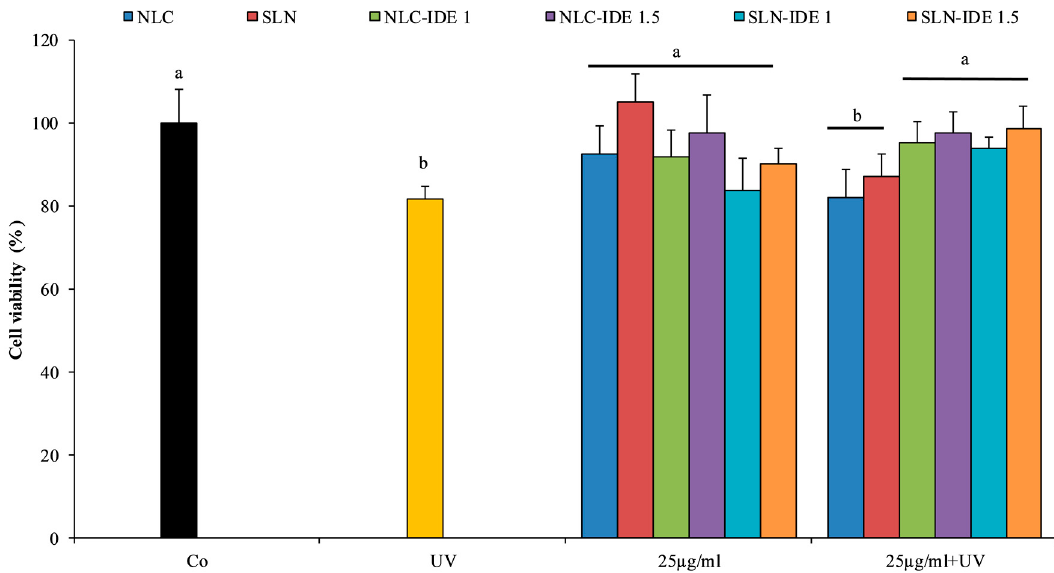
Figure 6. Effect of IDE-loaded SLN and NLC on the vitality percentage of HS68 fibroblast cells exposed to UV radiation: control cells not treated with compounds and not exposed to UV (Co); cells treated with UV radiation alone (UV); cells treated with 25 μ g/mL of IDE-loaded SLN or NLC and not exposed to UV (25 μ g/mL); cells pre-treated with IDE-loaded SLN or NLC (25 μ g/mL) and subsequently exposed to UV radiation (25 μ g/mL + UV). Each data is presented as mean ± SD (n = 12). Different superscript letters indicate a significant difference compared to the control ( p < 0.05).